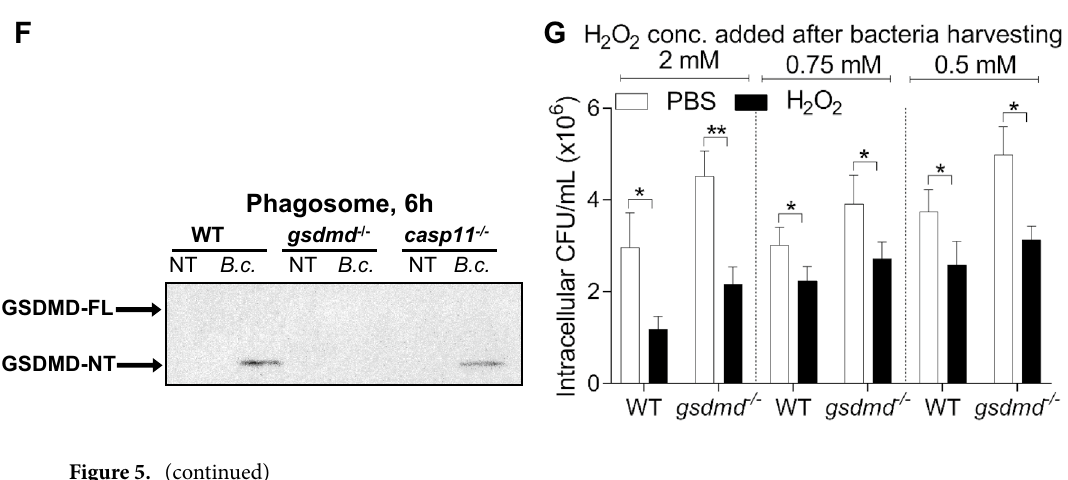
Figure 5. GSDMD contributes to bactericidal mROS production during B. cenocepacia infection. (A) Macrophage associated CFU of B. cenocepacia ( B.c.) (MOI10) in WT, gsdmd −/− , and casp11 −/− macrophages in presence and absence of N-acetylcysteine (NAC) (3 mM). Data represent mean ± SEM (n = 3). Statistical analysis was performed using two-way ANOVA. (B) Mitosox assay in WT, gsdmd −/− , and casp11 −/− macrophages infected with B. cenocepacia ( B.c. ) (MOI10) at 6 h post-infection in absence or presence of glycine (5 mM). Data represent mean ± SEM (n = 8). Statistical analysis was performed using two-way ANOVA. (C) Fold change comparing the addition of Mitotempo (MT) (20 µM) treatment in macrophage associated CFU of B. cenocepacia (MOI10) in WT, gsdmd −/− , and casp11 −/− macrophages at 6 h infection. Data represent mean ± SEM (n = 10). Statistical analysis was performed using two-way ANOVA. (D) TMRM assay in WT and gsdmd −/− macrophages infected with B. cenocepacia (MOI10) at 6 h post-infection. FCCP (uncoupler cause mitochondrial membrane potential (MMP) dissipation) (10 µM) was included as negative control. Fluorescence values were normalized to cell number as measured per well before normalization to the fluorescence of the non-infected wells. Data represent mean ± SEM (n = 12). Statistical analysis was performed using two-way ANOVA. (E) Cytokine release from WT, gsdmd −/− , and casp11 −/− macrophages treated as in ( C ). Data represent mean ± SEM (n = 11). Statistical analysis was performed using paired one-tailed student’s t-test. (F) Immunoblot analysis of GSDMD in isolated phagosomes from WT, gsdmd −/− , and casp11 −/− macrophages infected with B. cenocepacia (MOI10) at 6 h post- infection. (G) CFU of B. cenocepacia harvested from WT and gsdmd −/− macrophages and treated with H 2 O 2 for 30 min before plating. Data represent mean ± SEM (n = 3). Statistical analysis was performed using